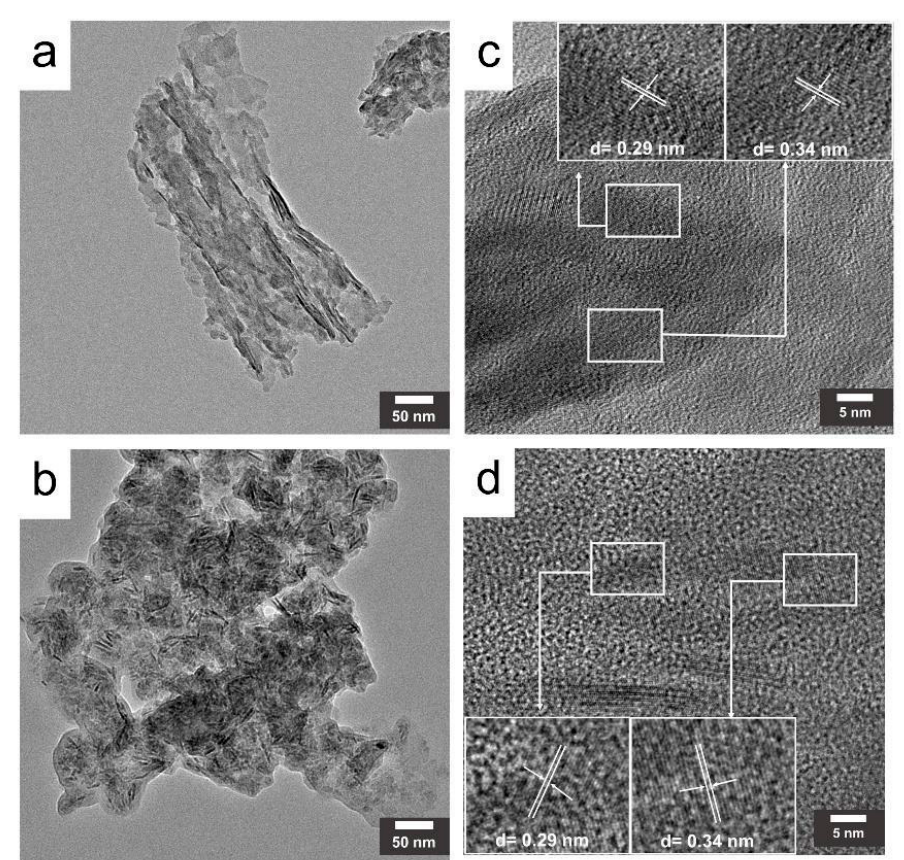
Figure 4. TEM images of ( a ) FSBC-450 and ( b ) FSBC-600 and HR-TEM images of ( c ) FSBC-450 and ( d ) FSBC-600.